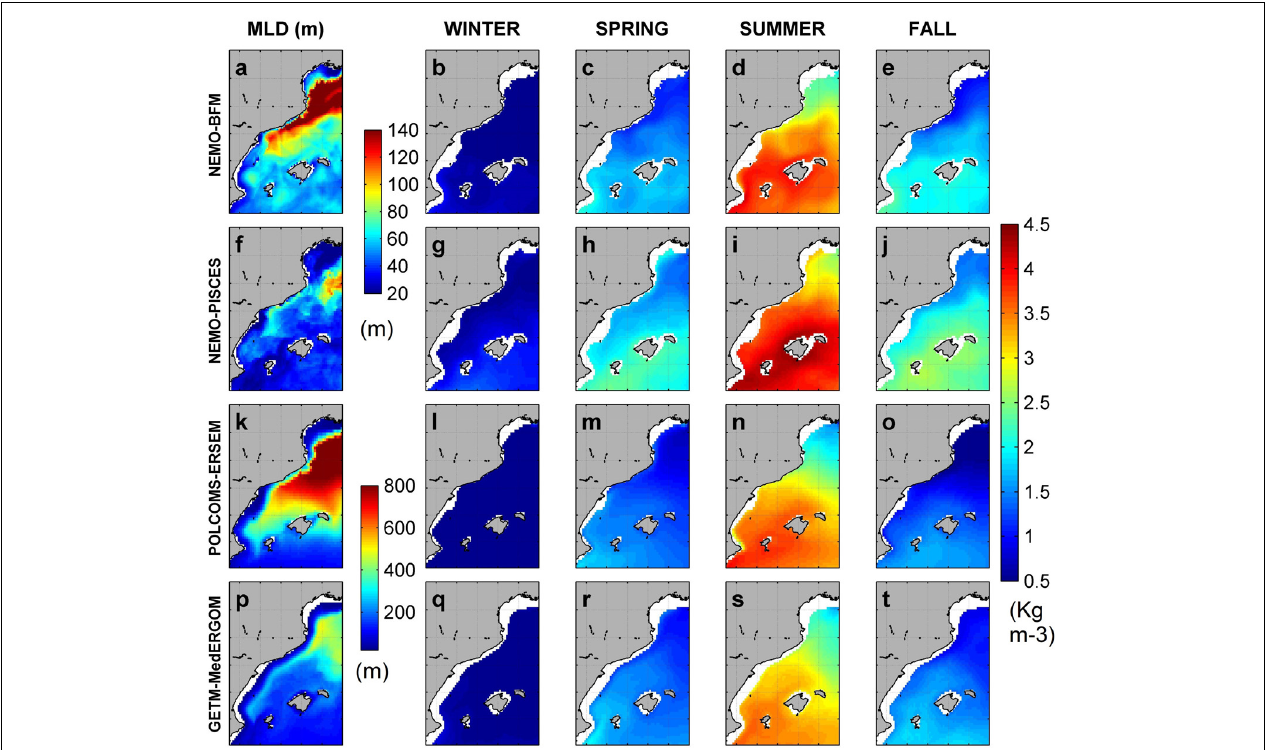
FIGURE 4 | Mixed-layer depth (MLD) (m) in February (a,f,k,p) . Density difference (0–90 m) through seasons is shown for NEMO-BFM ( b–e) , NEMO-PISCES ( g–i) , POLCOMS-ERSEM (l–o) , and GETM-MedERGOM (q–t)